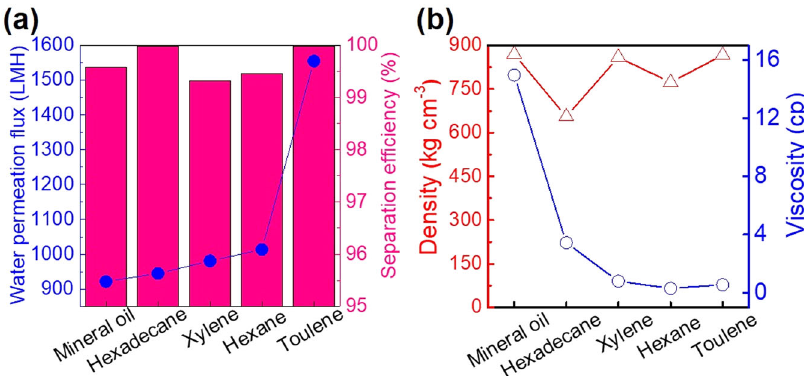
Fig. 6 Emulsion separation performance of coated membranes. a Water permeation fl ux and separation ef fi ciency for various light oils-in- water emulsions for coated MCE C membrane; b density and viscosity for various surfactant-stabilized O/W emulsions.